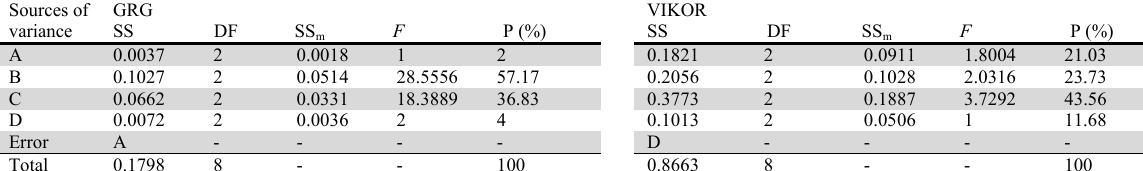
Results of ANOVA for GRG, and VIKOR Sources of